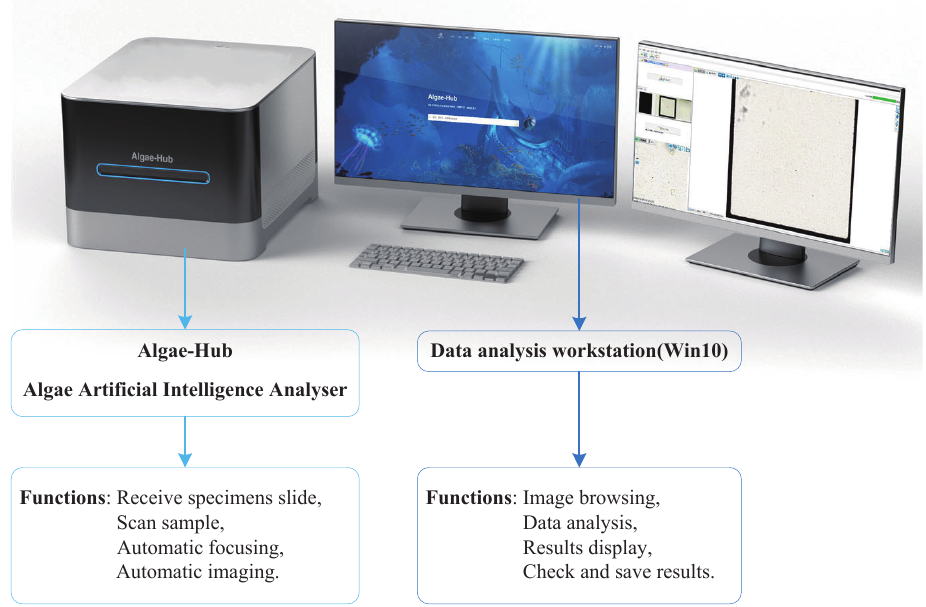
Figure 1. The demonstration picture of the algal self-organized detection system and the functions of its major